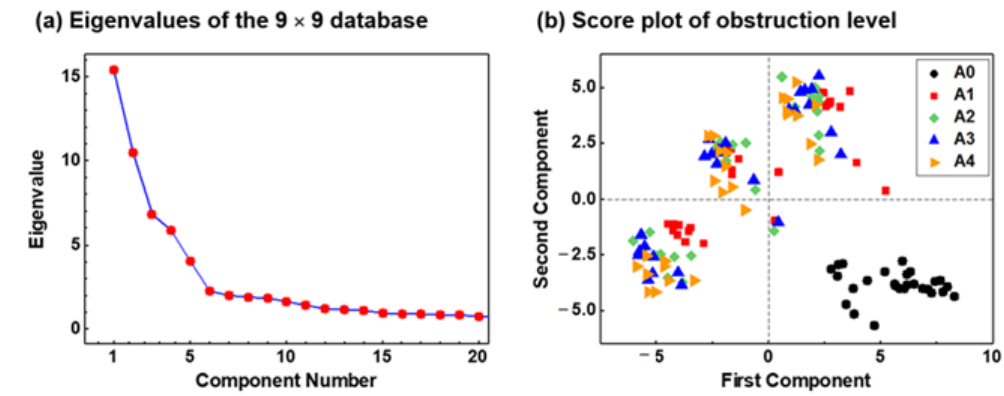
Figure 13. PCA-based quality check of images in the test case 3 that was mapped in a 9 × 9 matrix: ( a ) eigenvalues of the first 20 features, ( b ) score plot of the airway obstruction level vs. the first two features (principal components).